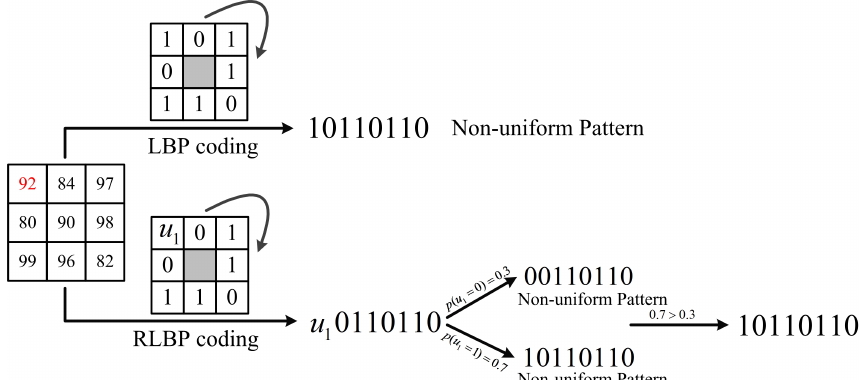
Figure 7. The comparison of LBP and RLBP patterns in a 3 × 3 sliding window with none pattern in uncertain RLBP pattern collection belongs to the uniform